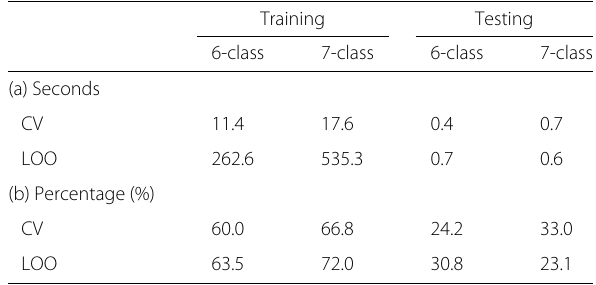
Table 18 Overall improvement in runtime when using Improved GLTP on JAFFE dataset